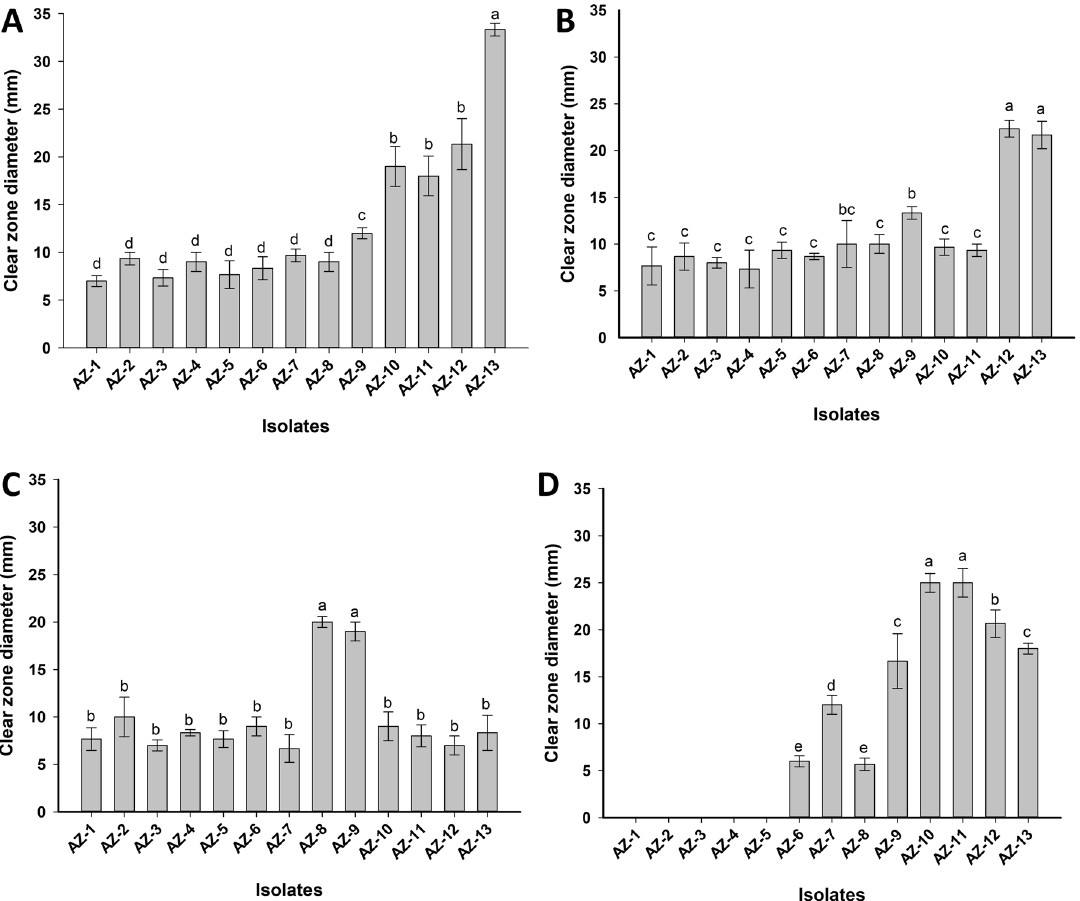
Fig. 9 The enzymatic activity of different fungal strains isolated from a historical manuscript (paper and leather bookbinding). A Is cellulase enzyme, B is amylase enzyme, C is gelatinase enzyme, and D is pectinase